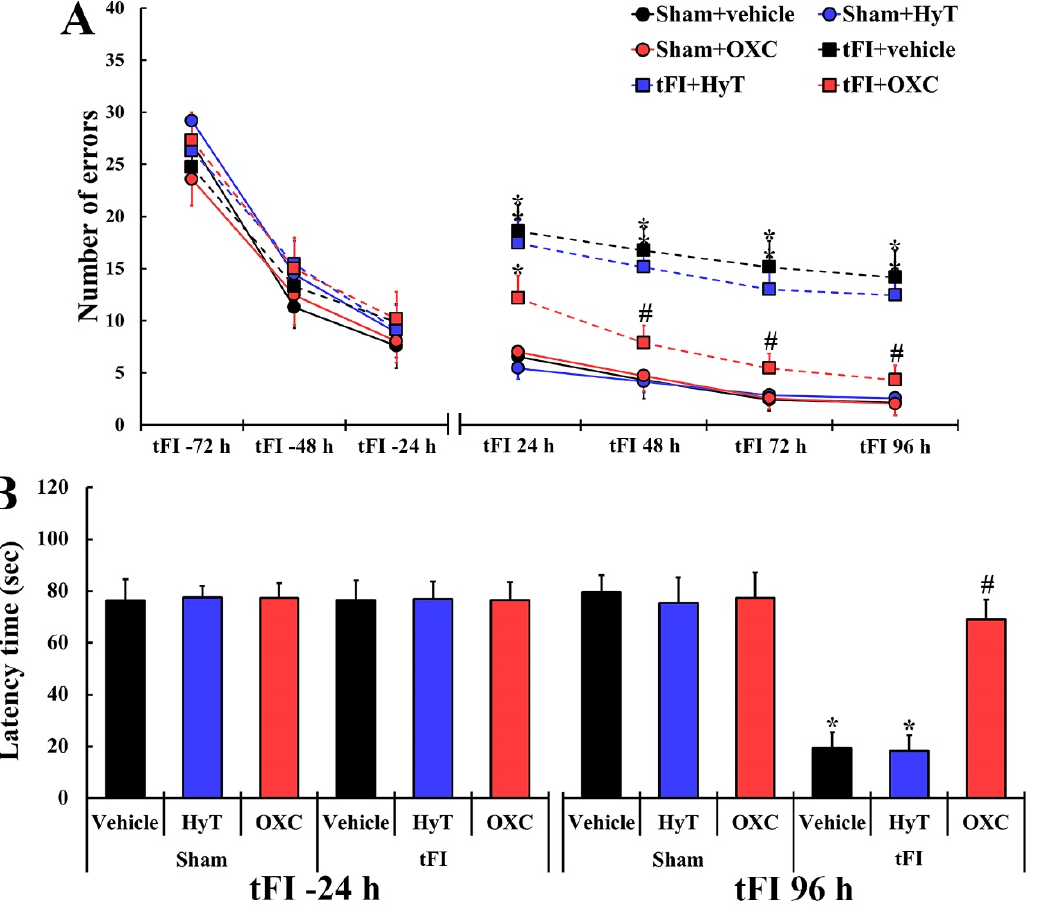
Figure 3. ( A ) The mean numbers of errors in the RAMT in all six groups at 72, 48, and 24 h before tFI/sham operation and 24, 48, 72, and 96 h after tFI/sham operation. The error number in the tFI+OXC group was significantly decreased from 48 h after tFI when compared with that in tFI+vehicle. ( B ) Latency time (seconds) in the PAT in all groups at 24 h before tFI/sham operation and 96 h after tFI/sham operation. The latency time shown in the tFI+OXC group was significantly increased when compared with that in the tFI+vehicle group. The bars indicate the means ± SEM ( n = 7 for each group; * p < 0.05 vs. sham+vehicle group; # p < 0.05 vs. corresponding time of the tFI+vehicle